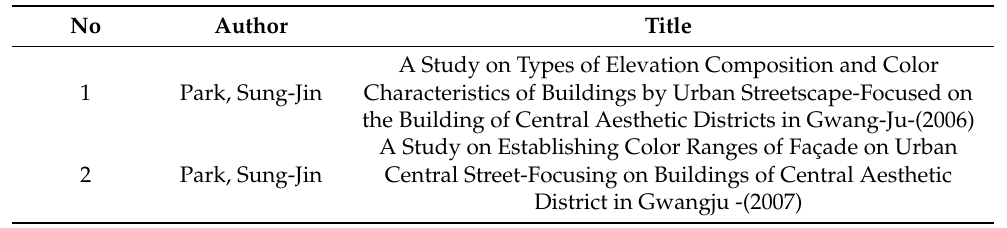
Table 1. Research related to façade